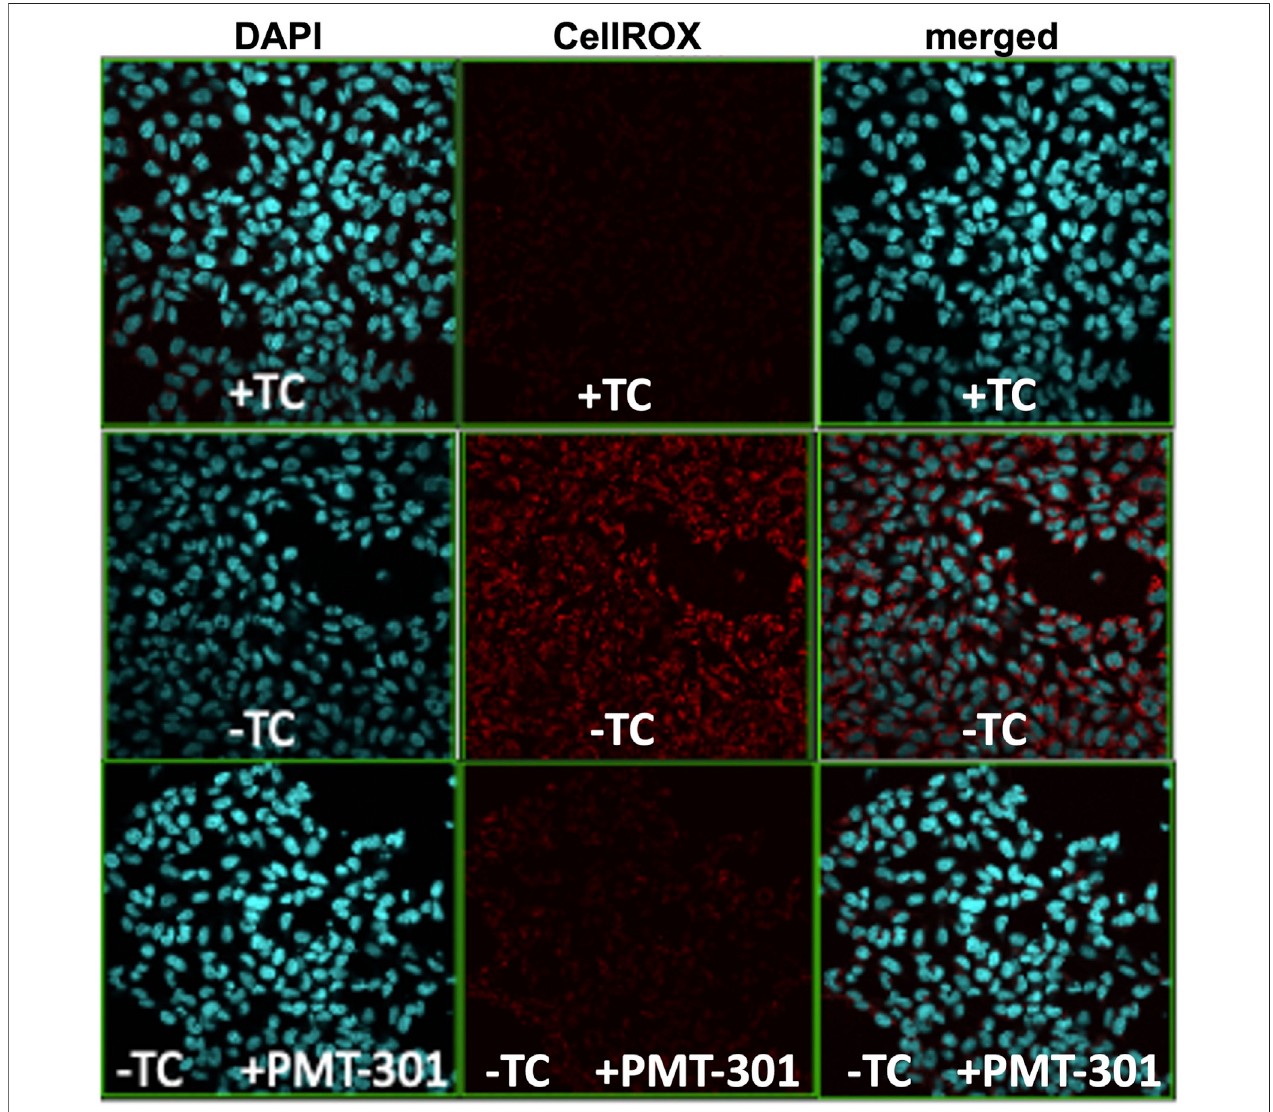
FIGURE 4 | Confocal imaging of the CellRox dye to measure the PAL reduction of oxidative stress. Induction of C99/Ab ( − TC) results in ROS production (red punctae in second row, center panel). PMT-301 reduces oxidative stress levels in MC65 cells (third row, center panel) to levels comparative to +TC protected state.